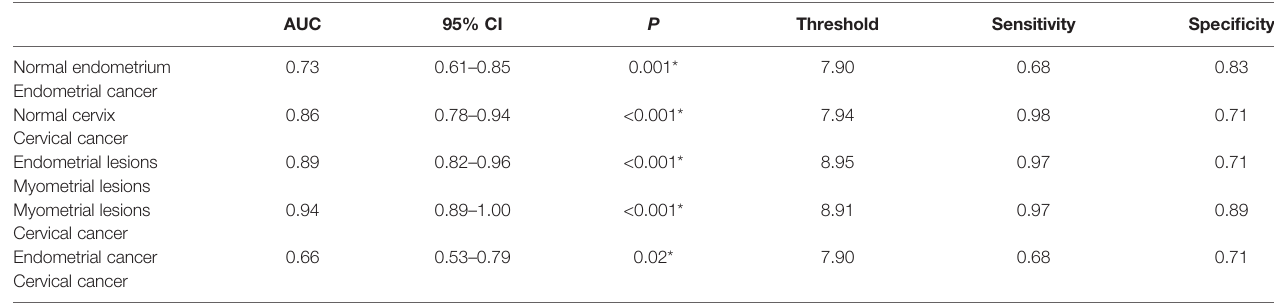
TABLE 5 | Related parameters of receiver operating characteristic